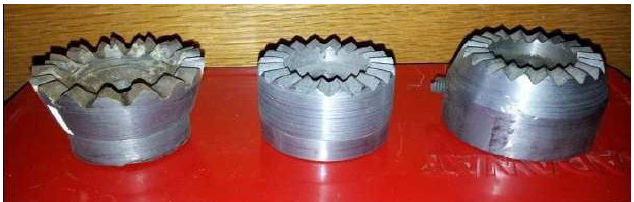
Fig. 2. Poles geometry